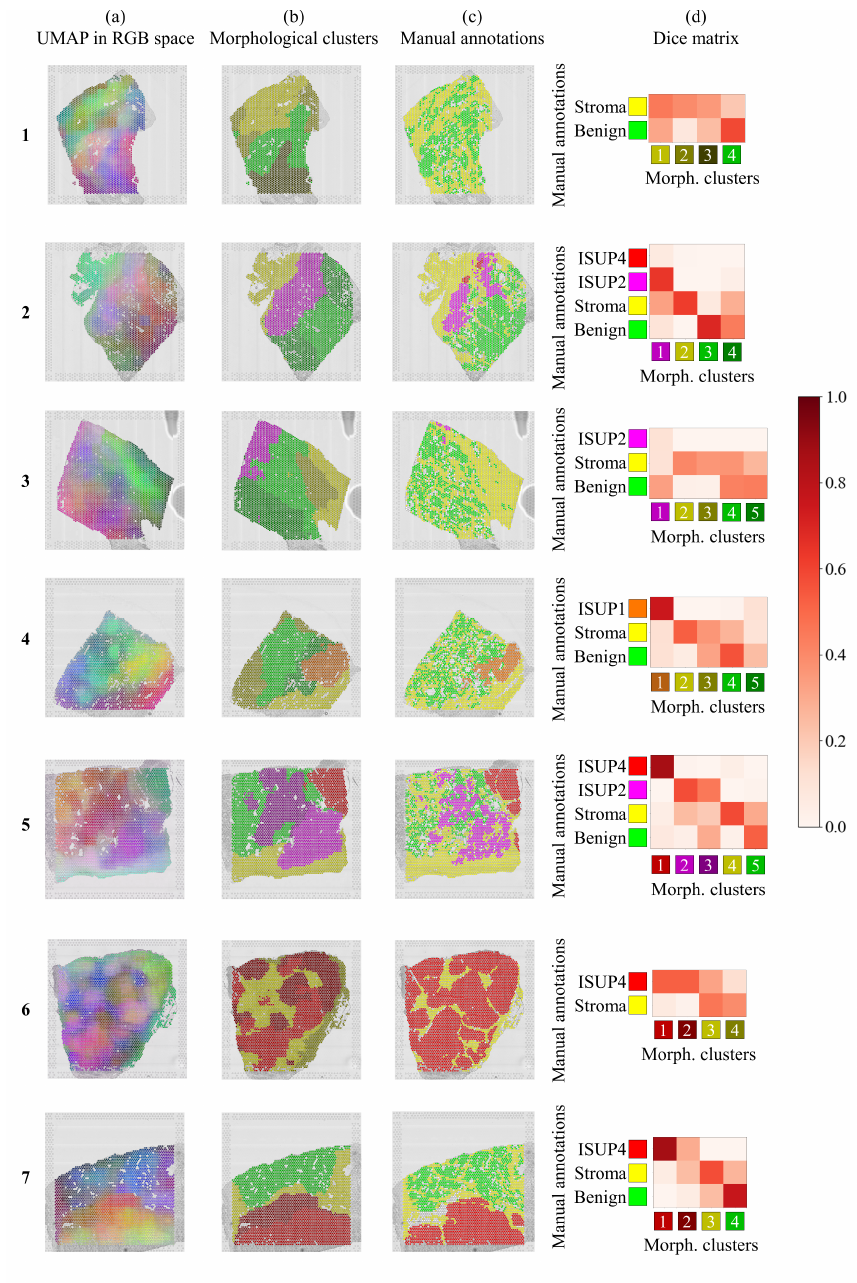
Figure 3. ( a ) Tissue heterogeneity is visualized by reducing the morphological feature space to three dimensions and presenting the morphological descriptors as RGB color maps. In this representation, a given color does not indicate any particular tumor grade. ( b ) Gaussian Mixture clustering using ten morphological descriptors provide clusters, where colors were deliberately chosen to match manual annotations. ( c ) Manual annotations of tumor grades performed by the histopathologists. In white color, we see spots excluded by the histopathologists that were not automatically discarded as being outside of the tissue by the ST method. ( d ) Dice matrices quantifying overlap between ( b , c ), the colorbar indicating the Dice coefficient, with values close to one representing exact spatial overlap, while values close to zero represent no spatial